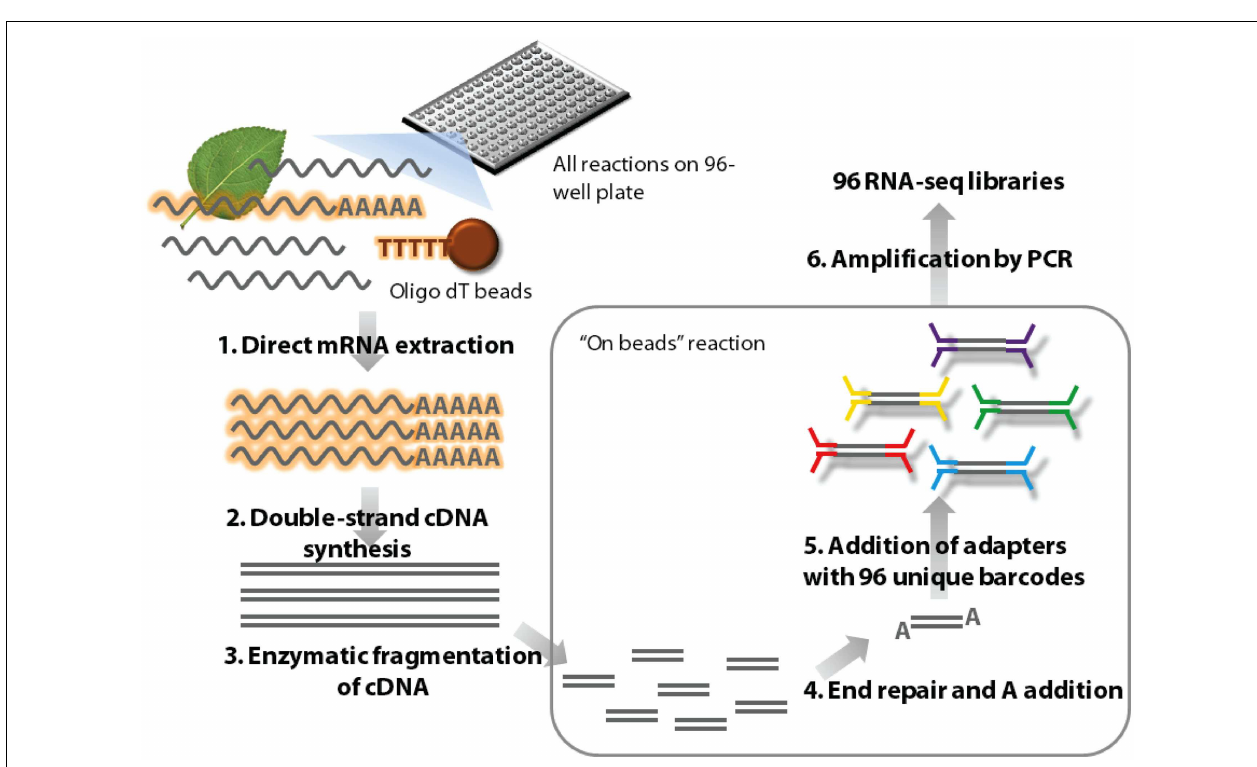
molecules are subsequently enzymatically fragmented (3).The ends of these molecules are repaired and an A nucleotide is added (4) to facilitateTA ligation of the barcoded adapters (5).The ligated samples are then enriched by amplification using adapter specific primers (6) and purified for